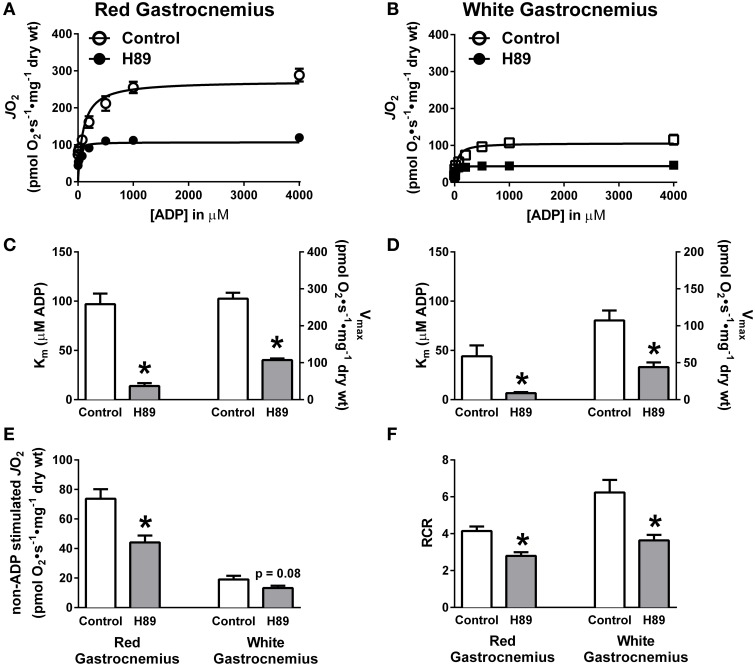
PKA regulates ADP kinetics, proton leak and respiratory control ratio in oxidative and glycolytic mouse PmFBs. ADP titration experiments were performed in RG (A) and WG (B) PmFBs with pyruvate and malate in the absence (open symbol) or presence (closed symbol) of 10 μM H89 in the assay media. Michaelis Menten-like kinetics generated from ADP titration experiments in RG (C) and WG (D). (E) Non-ADP stimulated JO2 was compared from ADP titration experiments in the absence (white bars) or presence (gray bars) of 10 μM H89 in RG (left) and WG (right). (F) Respiratory control ratio (ADP-stimulated JO2/non-ADP stimulated JO2) was calculated from ADP titration experiments in the absence (white bars) or presence (gray bars) of 10 μM H89 in RG (left) and WG (right). N = 4–6/condition. * denotes p < 0.05 compared to Control.